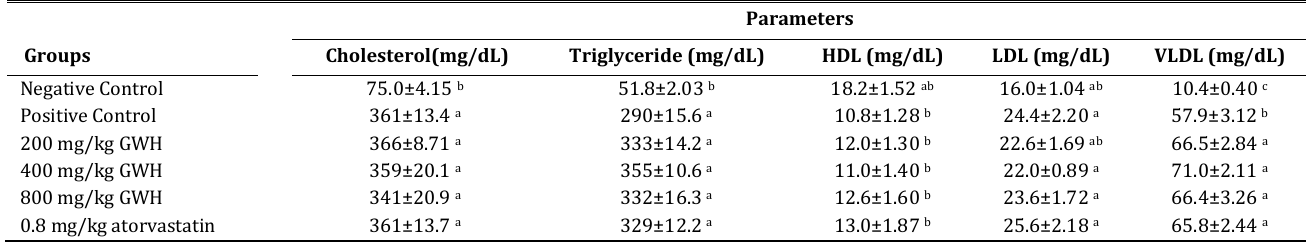
Table 1 . Effect of methanolic extract green walnut husk (GWH) on lipid profiles after 42 days of the experiment 1